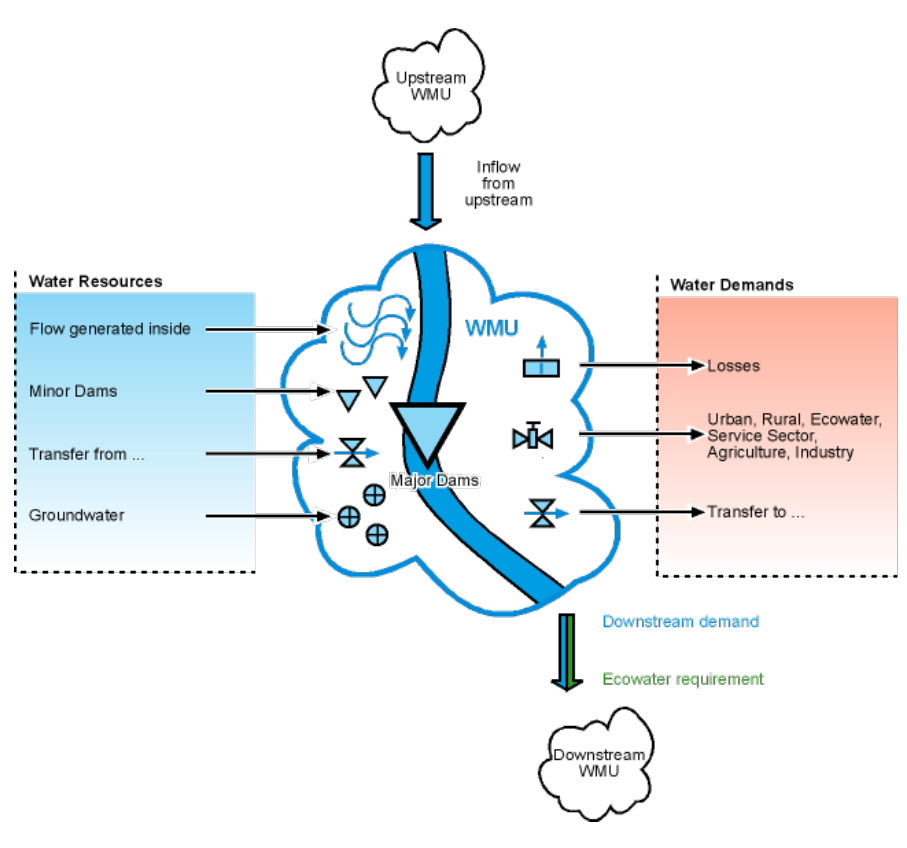
Figure 5. Components of the Water Balance Tool.